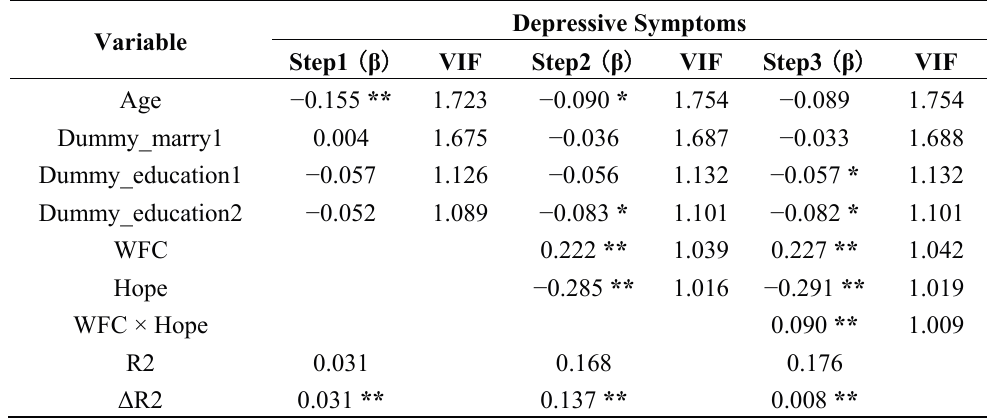
Table 6. WFC as the independent variable and hope as the moderator in the regression analysis.